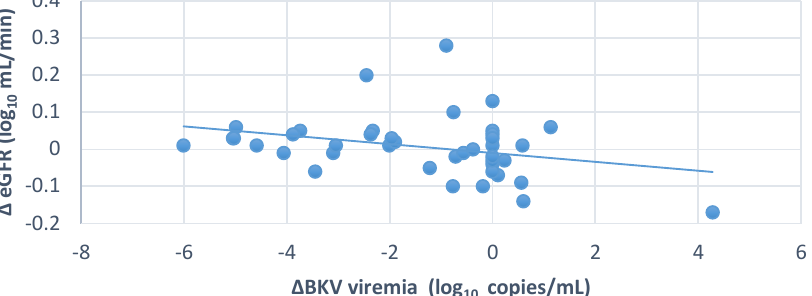
Figure 4. Relationship between changes in eGFR and changes in BKV viremia ( n = 41 KTx patients); r = − 0.314; p = 0.04.